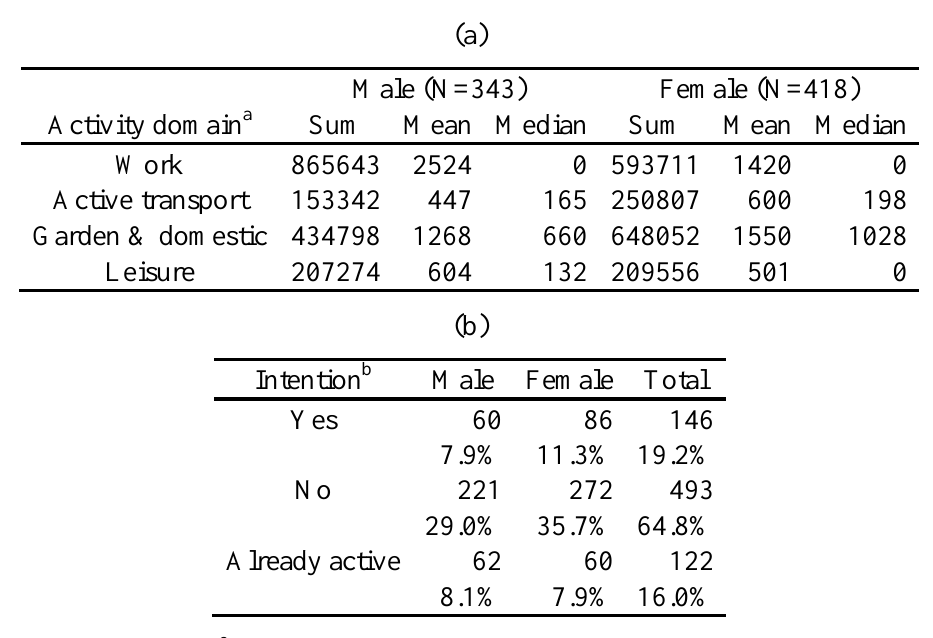
Table 2. Summary of: (a) participation in physical activity and (b) future intention to participate to recommended